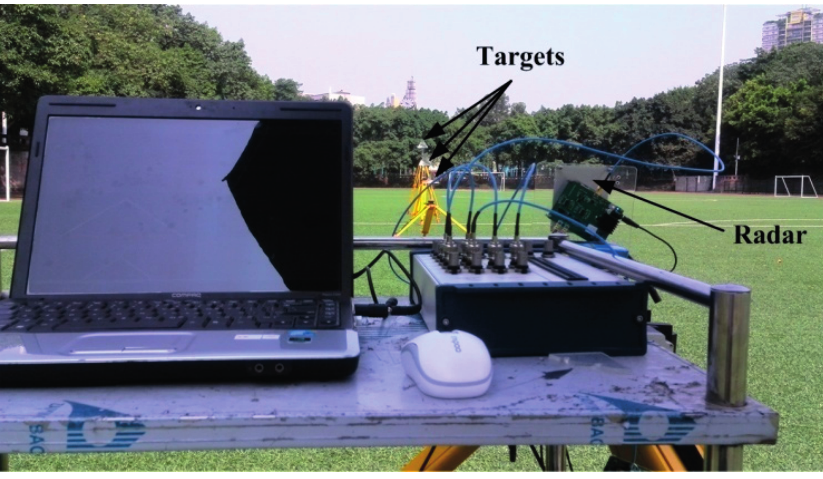
Figure 16. Photograph of the outdoor experiment with three targets.